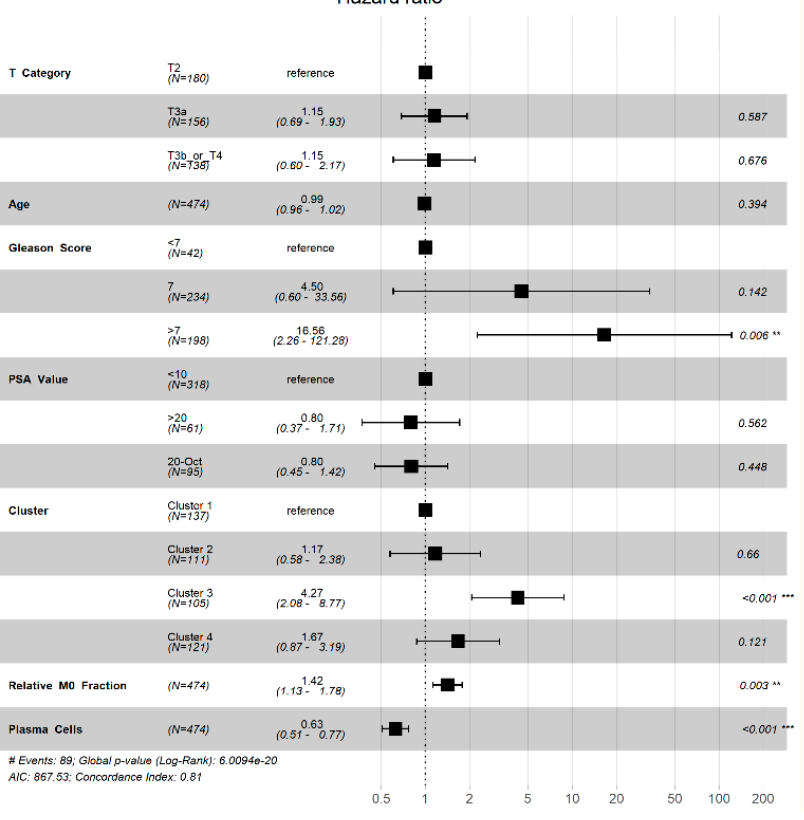
Figure 5. Multivariable analysis with hazard ratio (HR) represented in a Forest plot adjusting for age, pathologic T-stage, Gleason score, baseline PSA value, cluster, and fractions of predominant cells, including M0 macrophages and plasma cells. Clusters, cell types, and clinical risk factors are located in the left column, while hazard ratio calculations are located in the right column. ‘**’ denotes significance, 0.001 > p > 0.05, and ‘***’ denotes significance, p < 0.001.